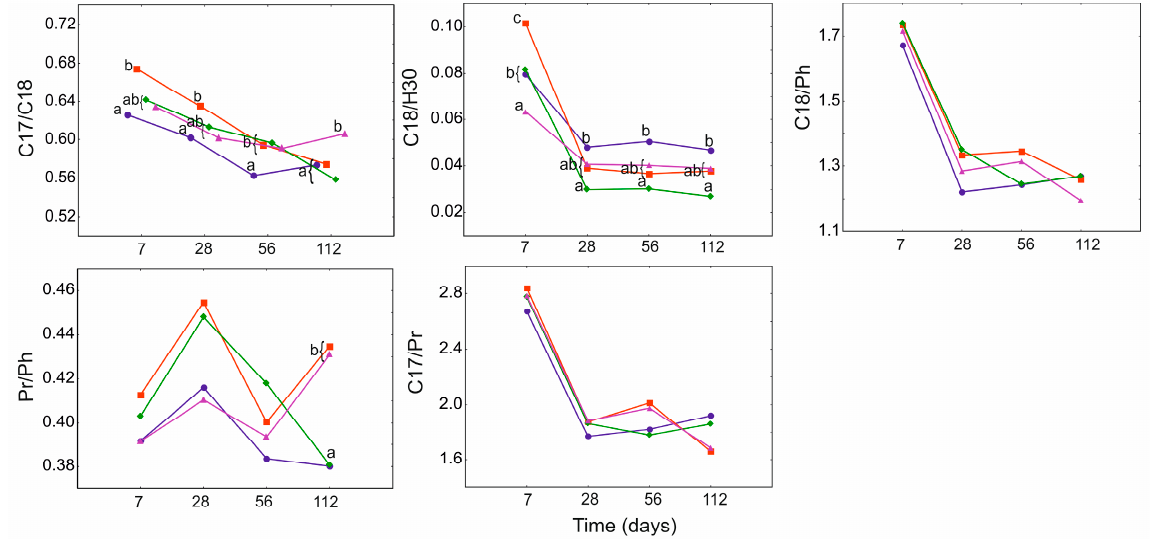
Figure 7. GLMM for geochemical ratios of grease for PGA treatment (blue and circle—PGA 0 , red and square—PGA 1 , green and diamond—PGA 1B , violet and triangle—PGA 10 ) and time (days). The different letters indicate the pairwise differences according to Duncan pairwise test. Mean values, standard error, and confidence intervals are included in Supplementary Material Table S1.